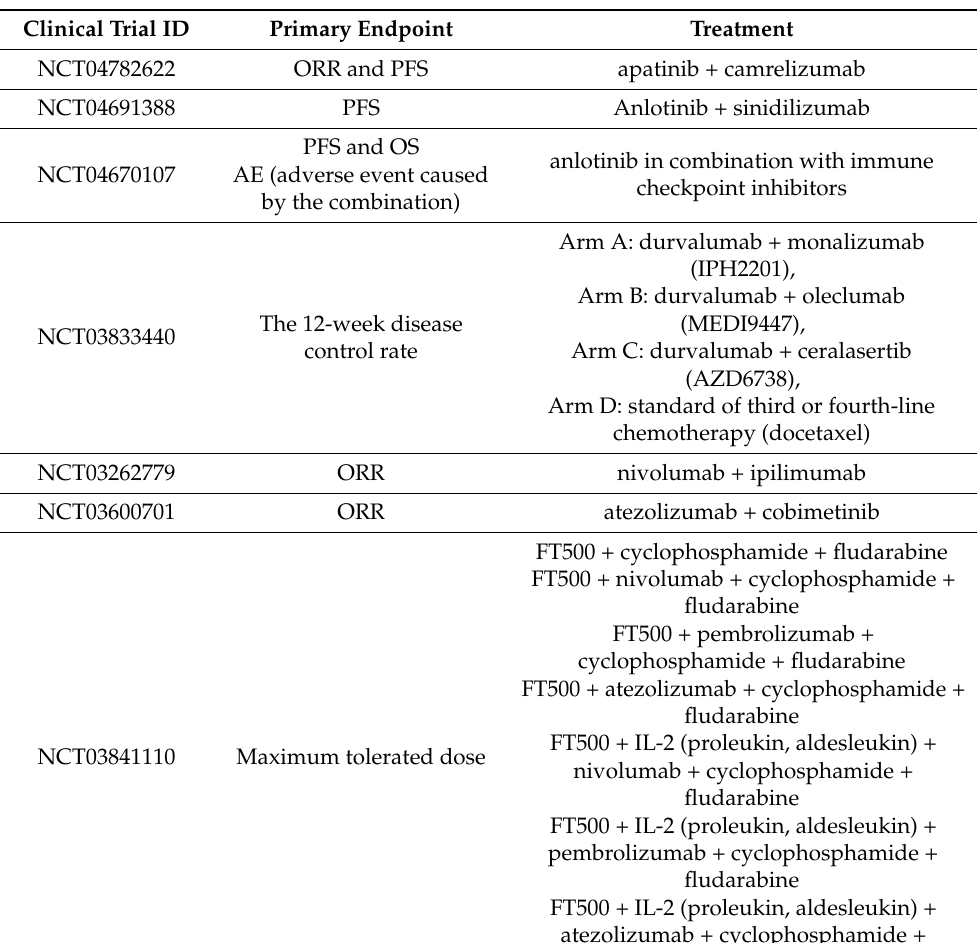
Table 2. Clinical trials on drug combinations and breaking down resistance to